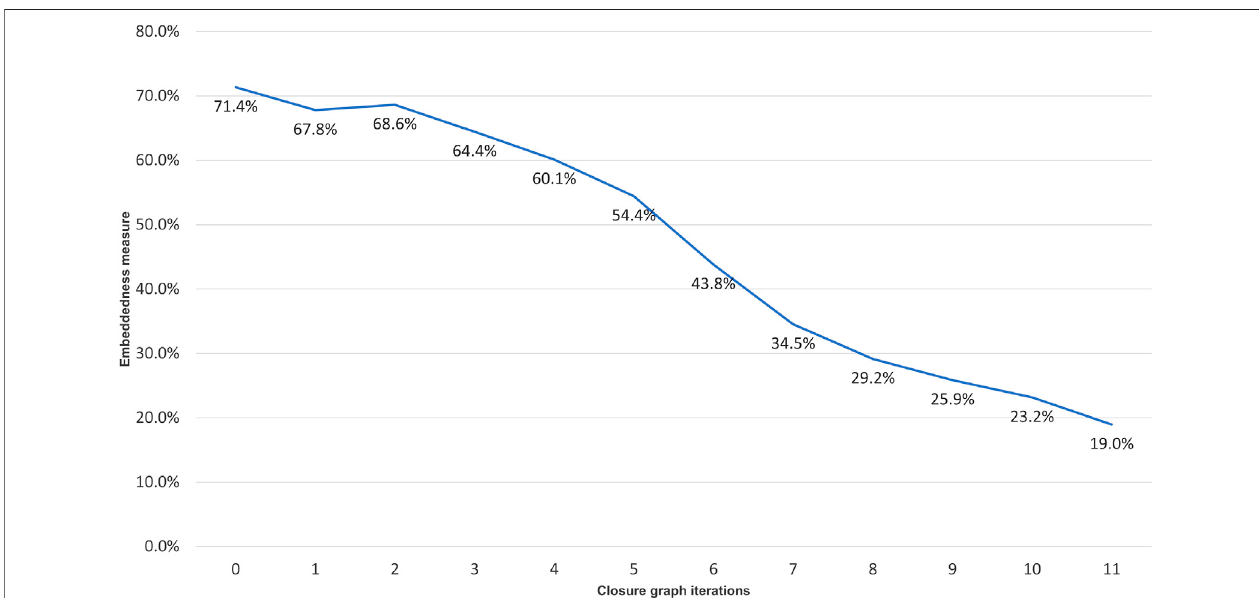
FIGURE 3 | Embeddedness, as de fi ned in (Fortunato and Hric, 2016), of the closure graph expansion per hop.